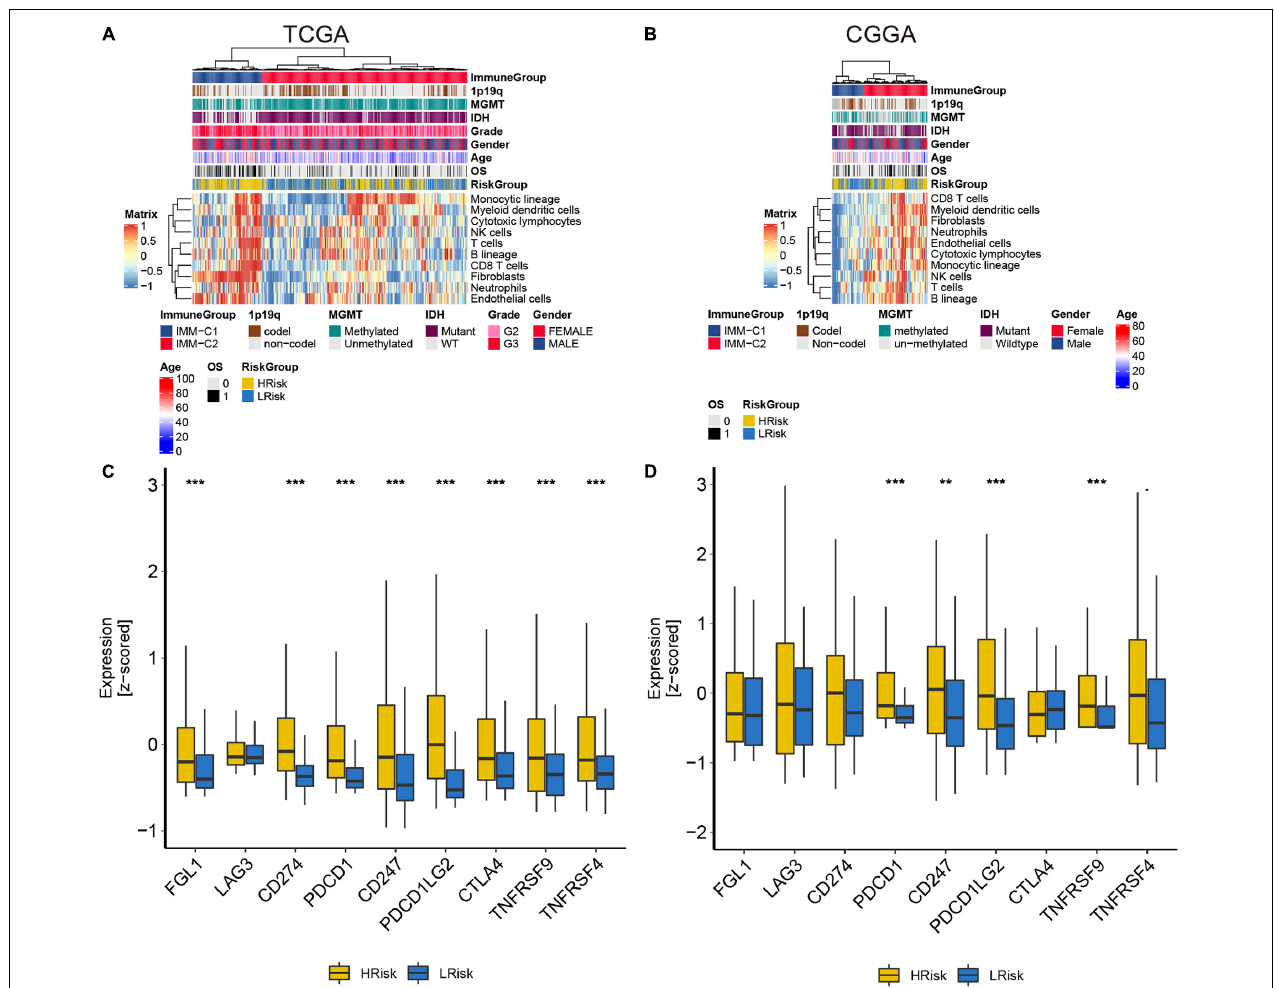
FIGURE 5 | The analysis of tumor immune infiltration in glioma patients in the TCGA and CGGA cohorts. (A,B) The heat maps of each immune cell score. (C,D) The expression of immune checkpoint-related genes. ** p < 0.01, *** p < 0.001.